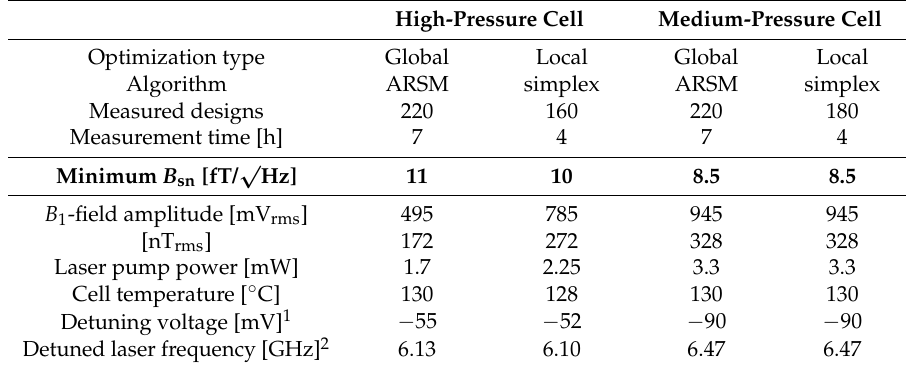
Table 1. Optimized shot-noise limited magnetic-field resolution B sn with the parameters of the optimization procedure (upper part) and the corresponding operational parameters (lower